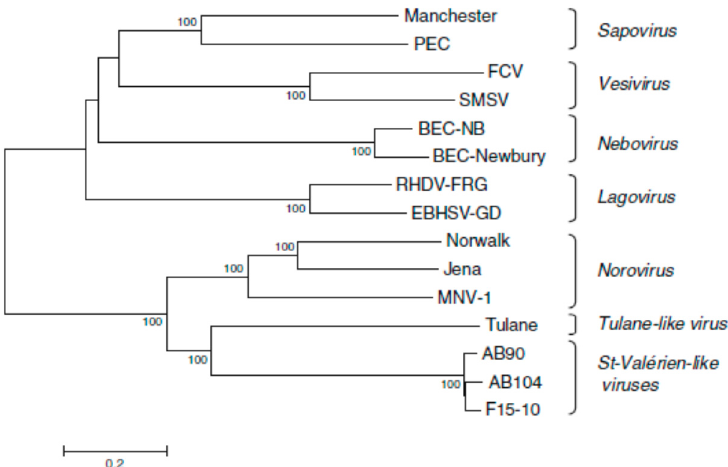
Figure 3. Phylogenetic tree based on nucleotide sequences of complete calicivirus genomes differentiating Valovirus as a separate genus. The tree was constructed by the neighbour-joining method MEGA 3.1. The confidence values at the branch points are based on 1000 bootstrap